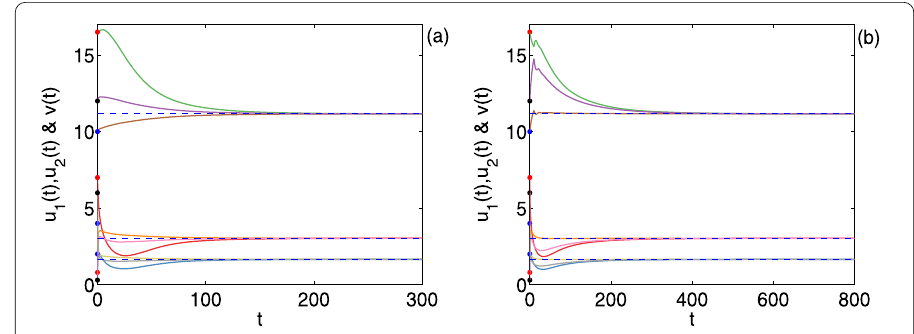
Figure 4 Time series of u 1 ( t ), u 2 ( t ) and v ( t ) generated by the model (1.5): Three initial values are chosen as ( u 1 (0), u 2 (0), v (0)) = (7,0.8,16.5),(2,4,10),(0.3,6,12) marked red points, blue points and black points, respectively. The dashed line stands for u 1 ( t ) = 3.025001035342410, u 2 ( t ) = 1.650000564732131 and